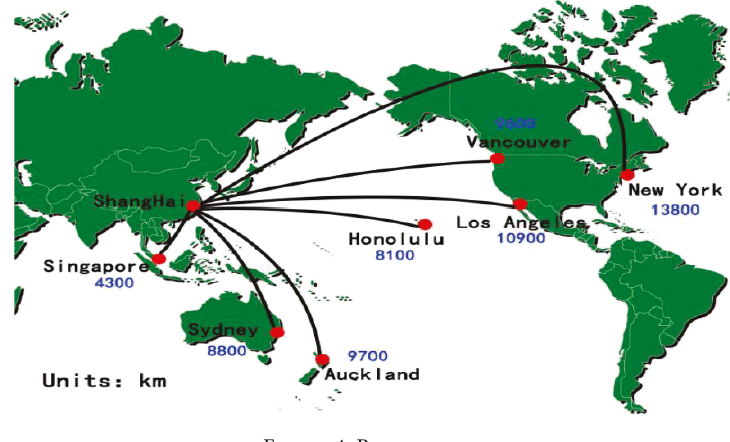
Figure 4: Range survey.